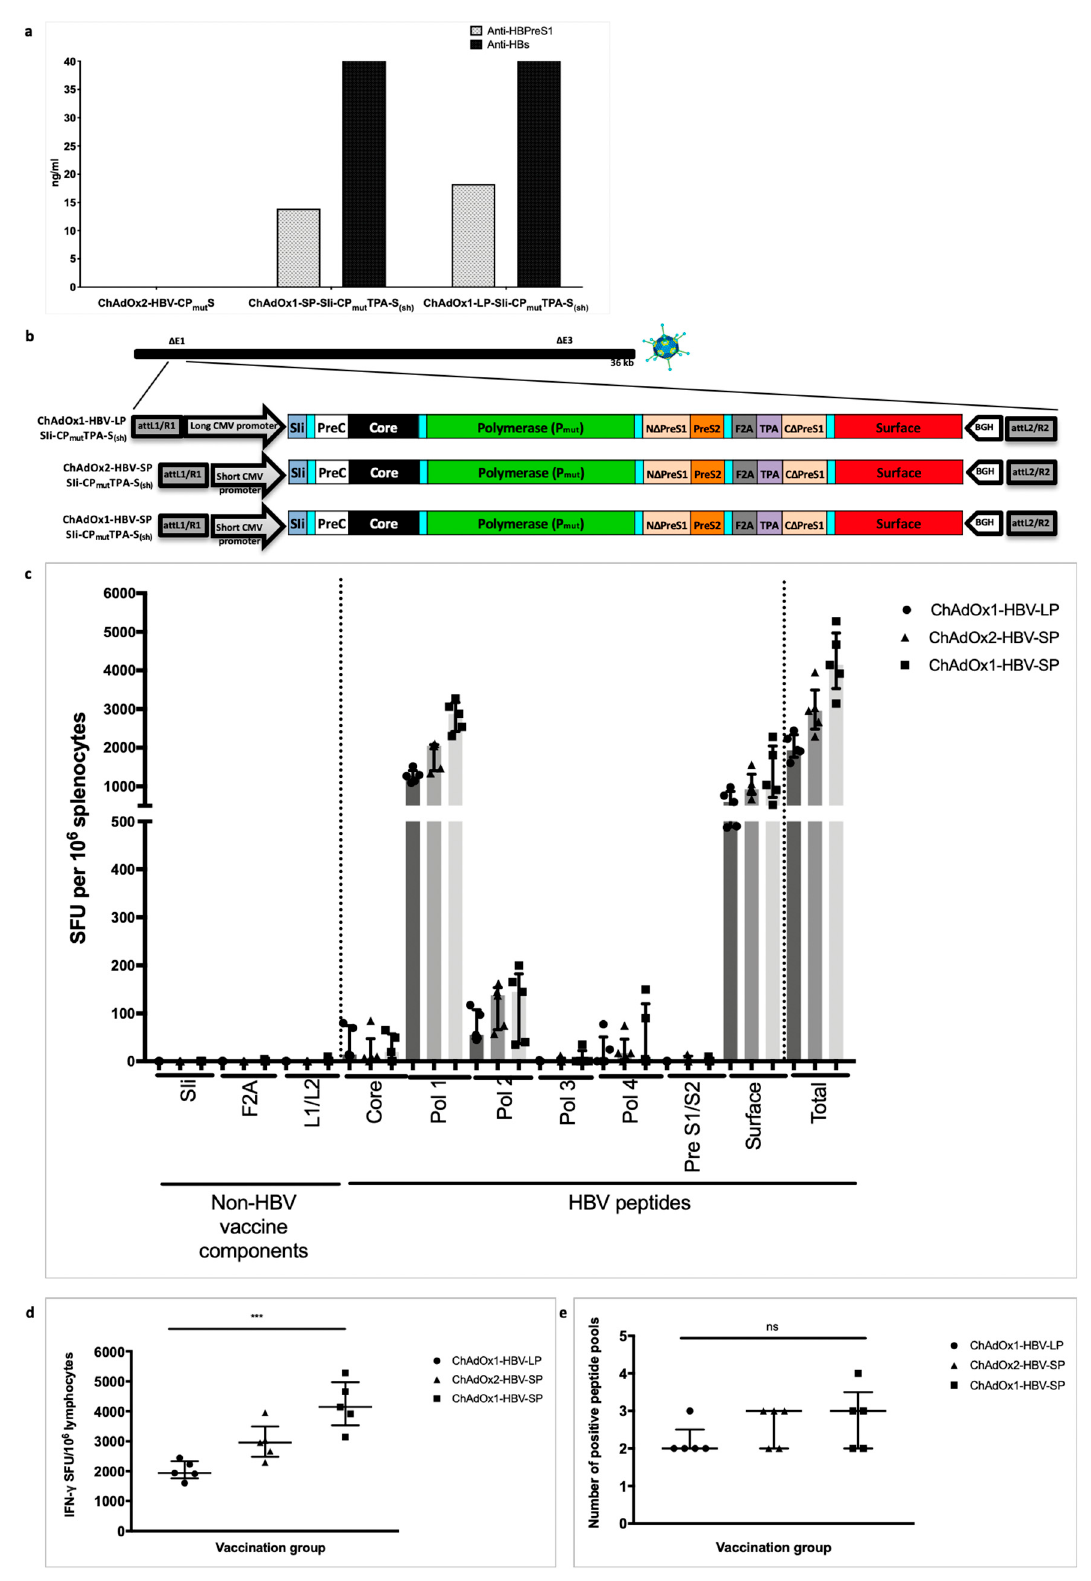
Figure 4. Second-generation HBV immunogen SIi-CP mut TPA-S (sh) design and immunogenicity of chimpanzee adenovirus (ChAd) vaccine candidates in inbred Balb/c mice. Supernatants from chimp-adenoviral HBV vaccine infected HEK293A cells were harvested 24 h post-infection and quantified in PreS1 and HBs antigen capture ELISA. PreS1 and S antigen quantities based on commercial standard recombinant HBV surface antigen (PIP002, Biorad) obtained from different chimp-adenoviral HBV